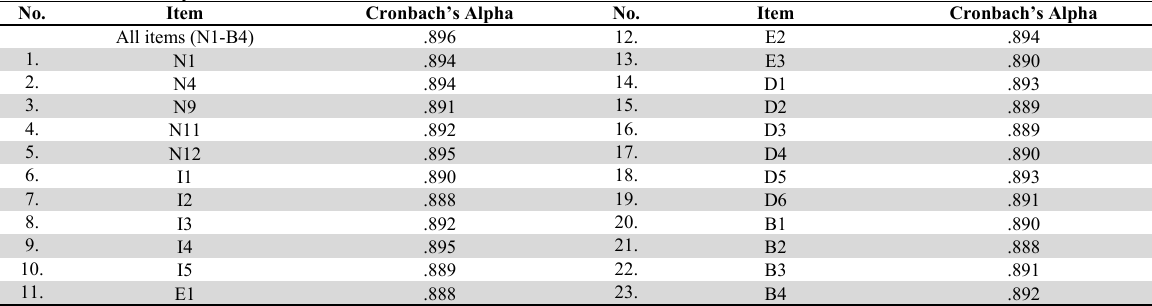
Results of Reliability